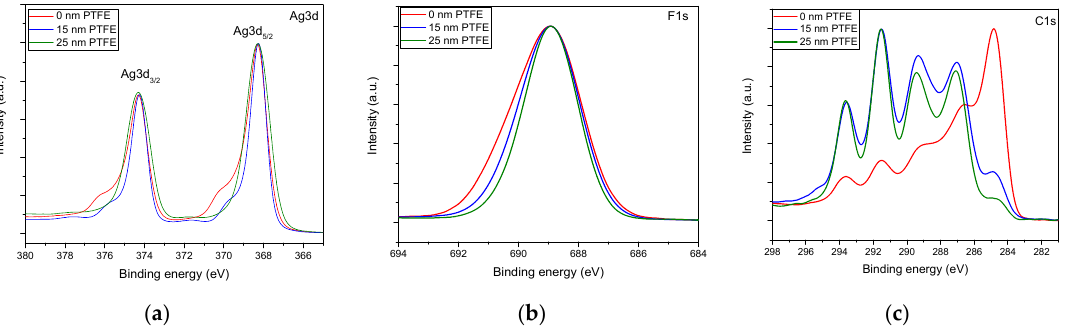
Figure 4. Evolution of the high-resolution spectra for various thickness of the PTFE barrier layer in the binding energy regions associated with ( a ) Ag 3d, ( b ) F 1s, and ( c ) C 1s.